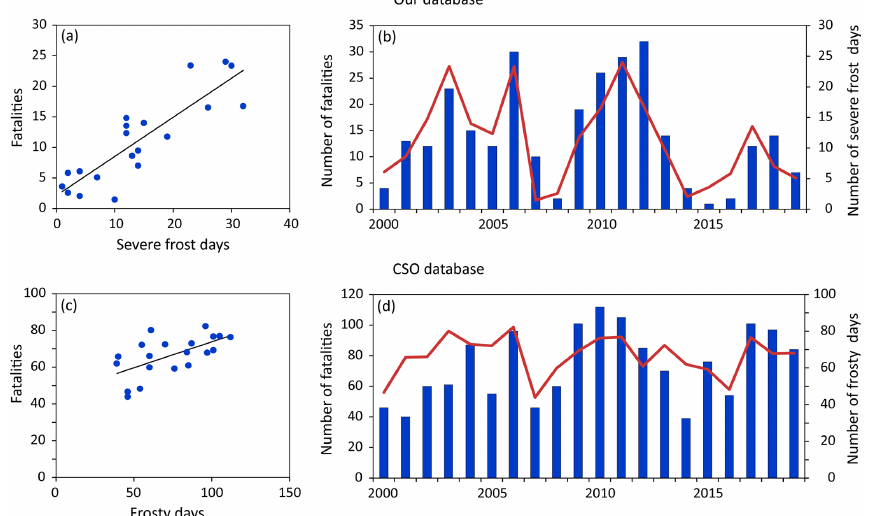
Figure 14. Relationships between DJF frost-related fatalities and temperature characteristics for the database created herein (a, b) and that of the Czech Statistical Office (c, d) in the 2000–2019 period: correlation fields of number of fatalities (a) with the number of severe-frost days (with T min ≤ − 10 . 0 ◦ C) and (c) with the number of frosty days and fluctuations (b) in the number of fatalities (columns) together with the number of severe-frost days (with T min ≤ − 10 . 0 ◦ C, red line) and (d) in the number of fatalities (columns) together with the number of frosty days (red